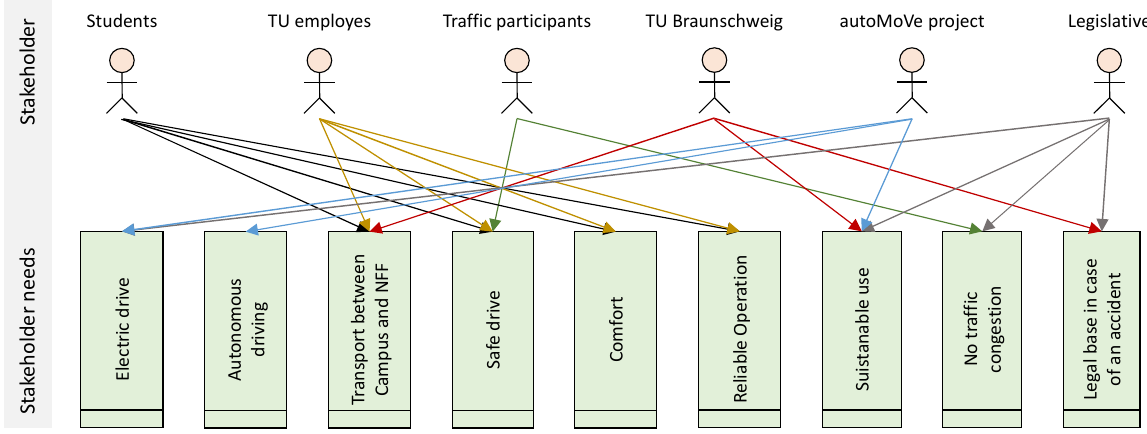
Figure 4. Case “people mover”: linking the stakeholders with the stakeholder needs.